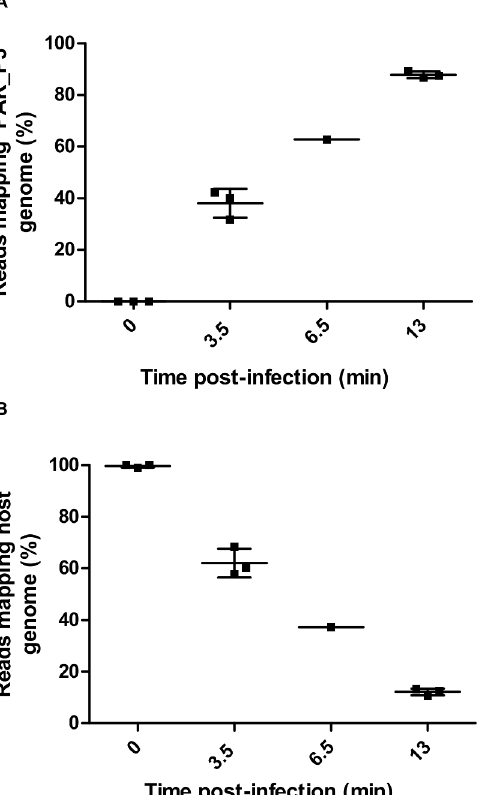
Fig 2. PAK_P3 takes over the host cell transcription over the course of infection. Three independent biological replicates of RNA extracts were harvested from PAK_P3 infected cells at 0min, 3.5min and 13min post infection, as well as a single sample collected at 6.5min and all were subsequently sequenced. Plotting the percentage of reads mapping to the PAK_P3 genome (A) and to the host genome (B) over the course of infection shows that PAK_P3 progressively dominates the transcriptional environment of the cell with phage